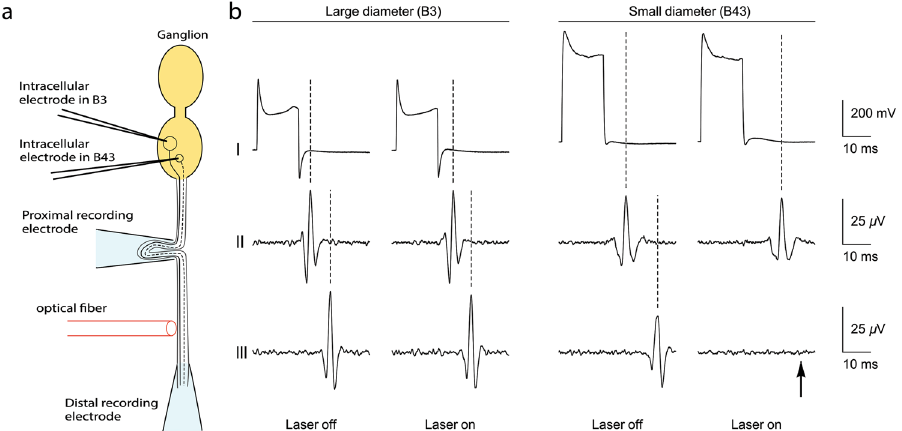
Figure 2. Selective block of an individual slower-conducting axon in Aplysia californica . ( a ) Experimental setup for selective optical inhibition. Two neurons, B3 and B43, were impaled and stimulated intracellularly. B3, a large-diameter cell, has a large-diameter axon, whereas B43, a small-diameter cell, has a small-diameter axon. Two suction recording electrodes were positioned along the length of the nerve, one proximal to the ganglion and one distal. The optical fiber (600 µ m diameter) delivering the IR energy (1860 nm wavelength) was placed perpendicularly to the nerve between the recording electrodes. ( b ) Action potential recording from the large- diameter soma (B3) and axon and the small-diameter soma (B43) and axon. (I) Intracellular stimulation applied to the cell body. (II) Proximal recording. (III) Distal recording beyond the IR laser application. The B43 small- diameter axon was completely blocked at a radiant exposure of 0.106 J/cm 2 /pulse (arrow) whereas the B3 large- diameter axon remained unaffected.